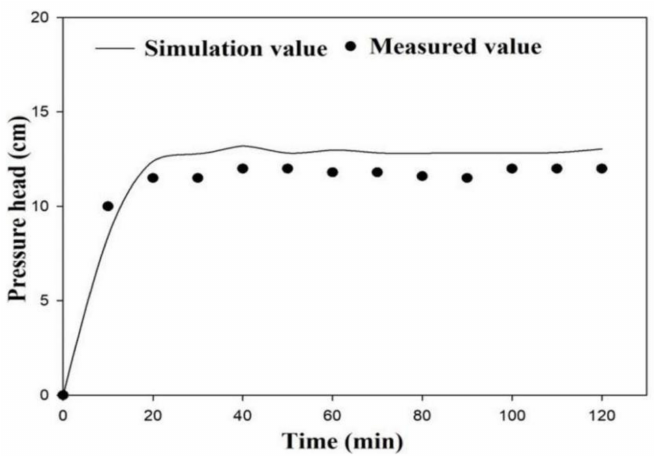
Figure 8. Fitting curve between measured and simulated values.